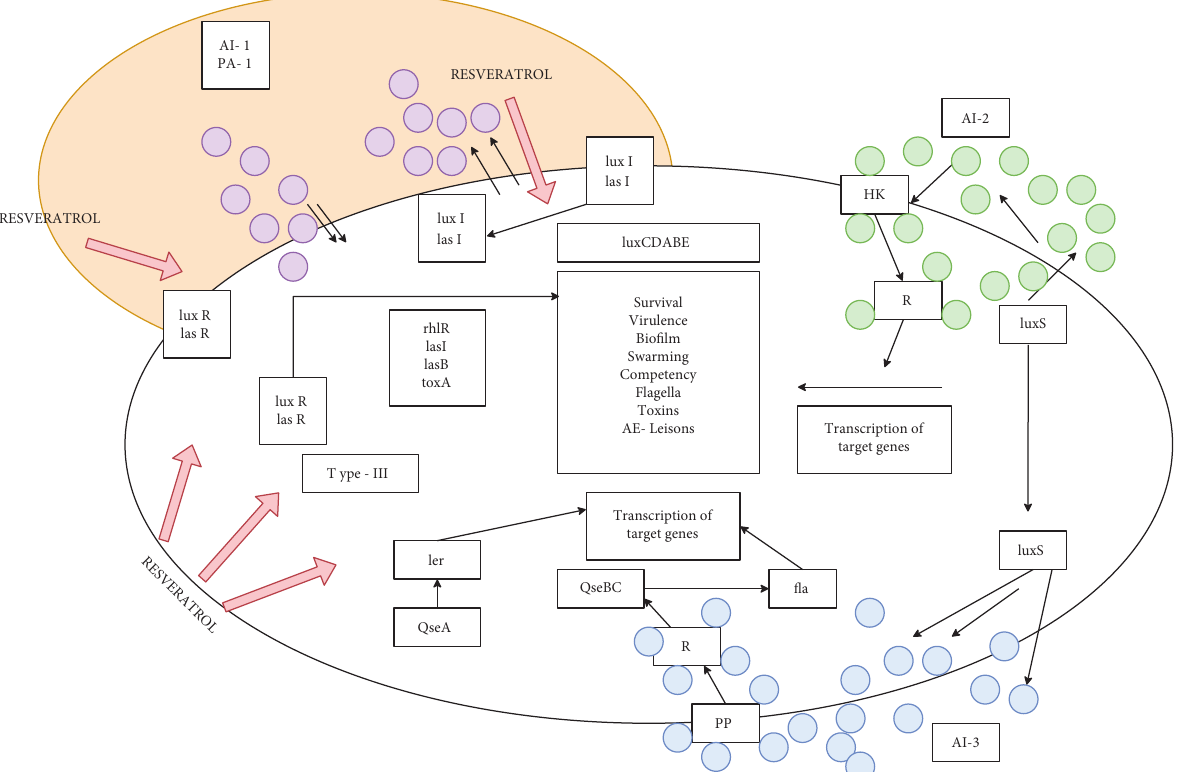
Figure 3: Representation of phytochemicals that inhibit quorum